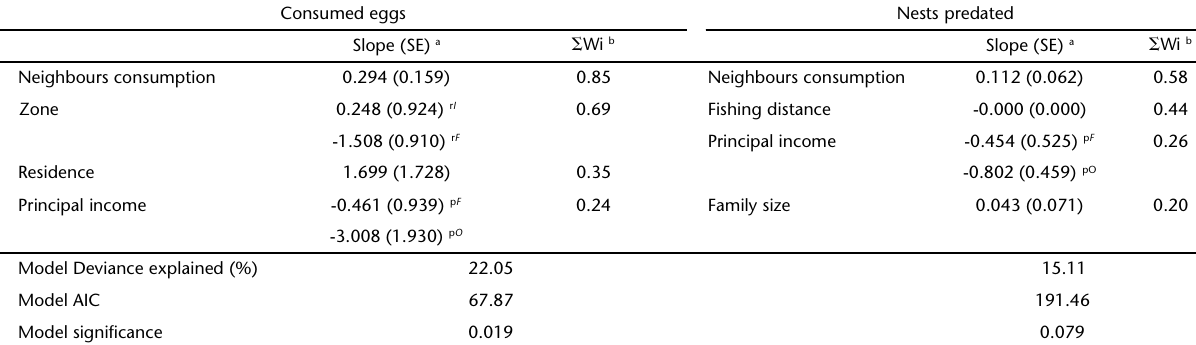
Table IV. Model weights and parameter (slope) estimates from information-theoretic analysis of Podocnemis unifilis egg predation by riverine residents around a protected area (FLONA) in northeast Brazil. The four most relatively important of 12 “Social”, “Economic” and “Spatial” variables were used to explain the responses of a) if respondents consumed P. unifilis eggs during the previous year (“Consumed eggs”) and b) how many nests the consumption of each respondent represented (“Nests